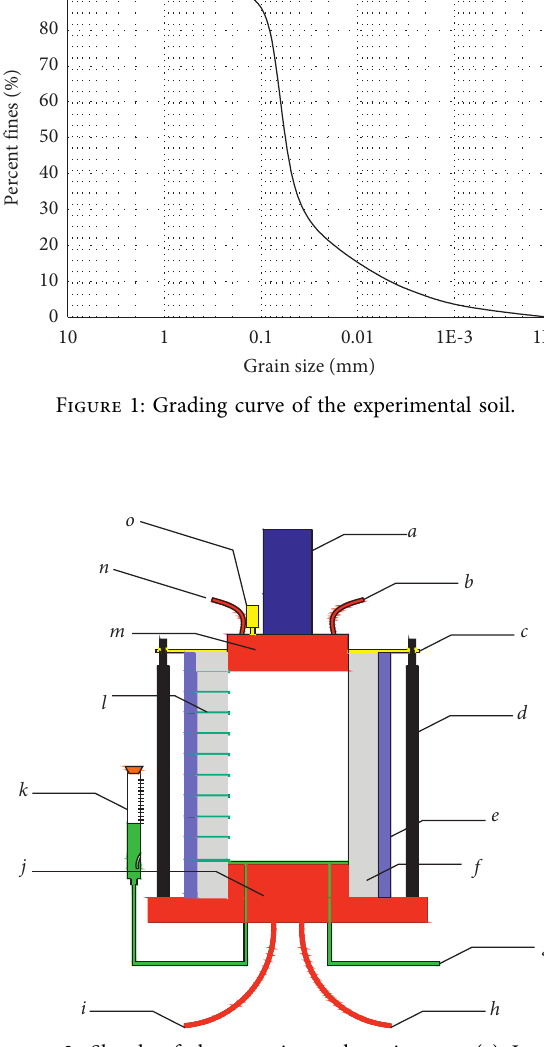
Figure 2: Sketch of the experimental equipment. (a) Loading piston; (b) cold-bath outlet; (c) ferrule; (d) fixed rod; (e) insulation layer; (f) sample-loading device; (g) drain hole; (h) cold-bath outlet; (i) cold-bath inlet; (j) bottom cold-bath plate; (k) Markovian bottle; (l) thermistor probe; (m) top cold-bath plate; (n) cold-bath inlet; (o) displacement